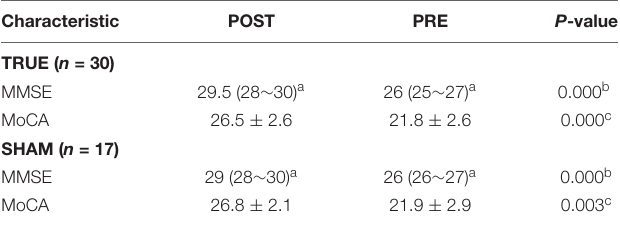
TABLE 3 | Mini-Mental State Examination and Montreal Cognitive Assessment scores before and after moxibustion treatment.